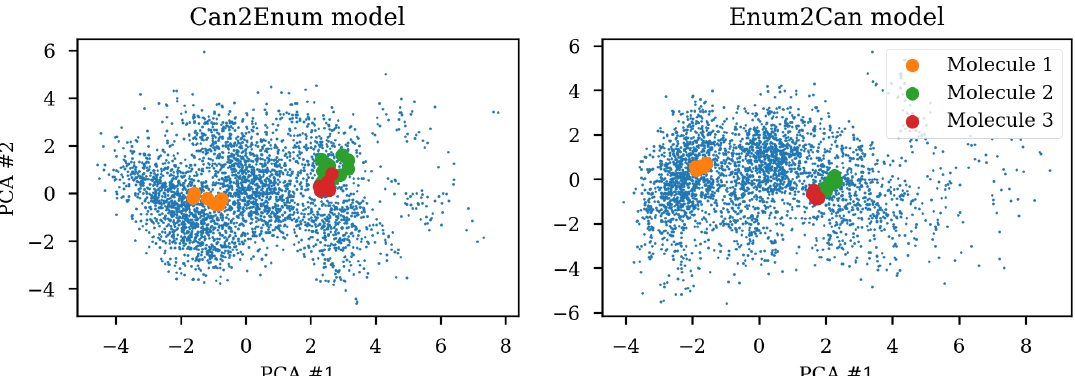
Figure 9. SMILES enumeration challenge of the GDB-8 dataset based Enum2can and Can2enum encoders. The same three molecules were encoded from 10 enumerated SMILES and projected to the latent space reduced to two dimensions with principal components analysis (PCA). Using enumerated SMILES for training of the encoder leads to the tightest clustering, but also training with the enumerated SMILES in the decoder improves the clustering (c.f. Figure 1). Small blue dots are the test set used for the PCA